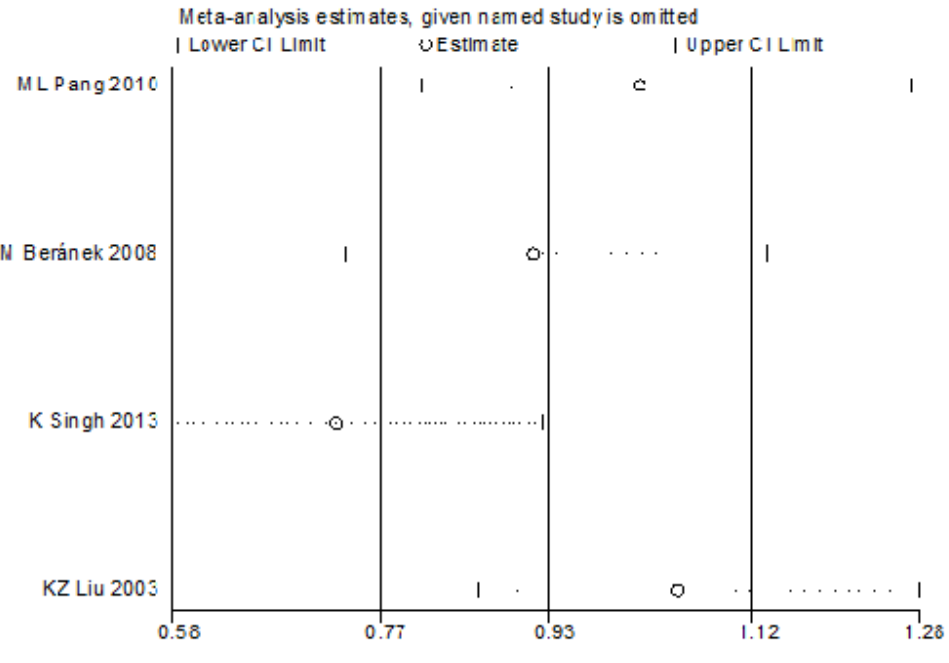
Figure 4. The sensitivity analysis for the association of MMP9-1562C/T gene polymorphism with risk of diabetic microvascular